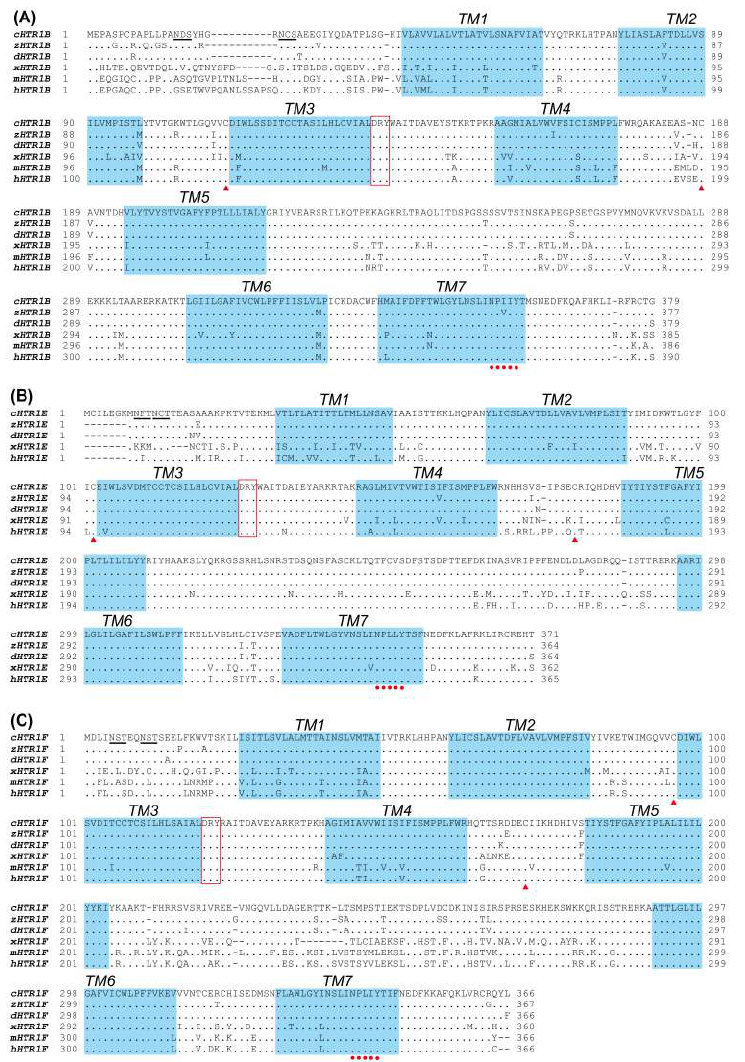
Figure 1. Amino acid sequence alignment of chicken HTR1B, HTR1E, and HTR1F with that of other species. ( A ) Amino acid alignment of chicken HTR1B (cHTR1B, XP_015140120.1) with that of zebra finch (zHTR1B, XP_002190169.2), ducks (dHTR1B, XP_005017926.2), Xenopus tropicalis (xHTR1B, XP_002936251.2), mice (mHTR1B, NP_034612.1) and humans (hHTR1B, NP_000854.1). ( B ) Amino acid alignment of chicken HTR1E (cHTR1E, MK139005) with that of zebra finch